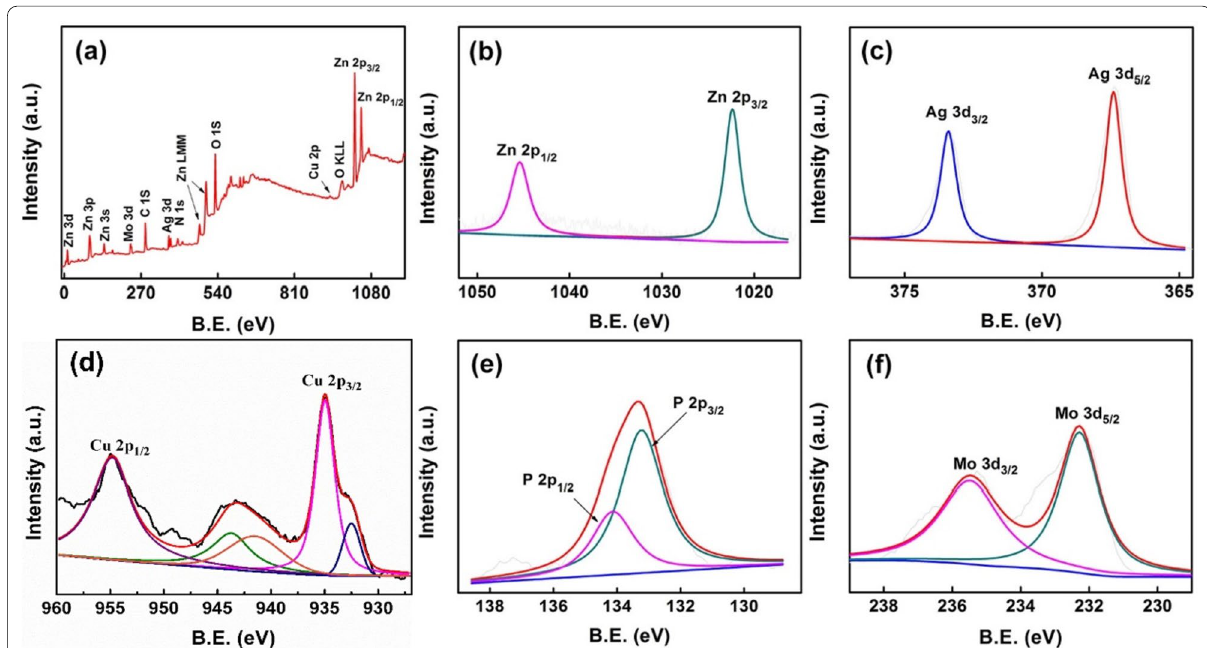
Fig. 4 XPS spectra of AgZnO/POMs nanocomposites a full spectrum, b Zn 2 p map, c Ag 3 d map, d Cu 2 p map, e P 2 p map, f Mo 3 d map